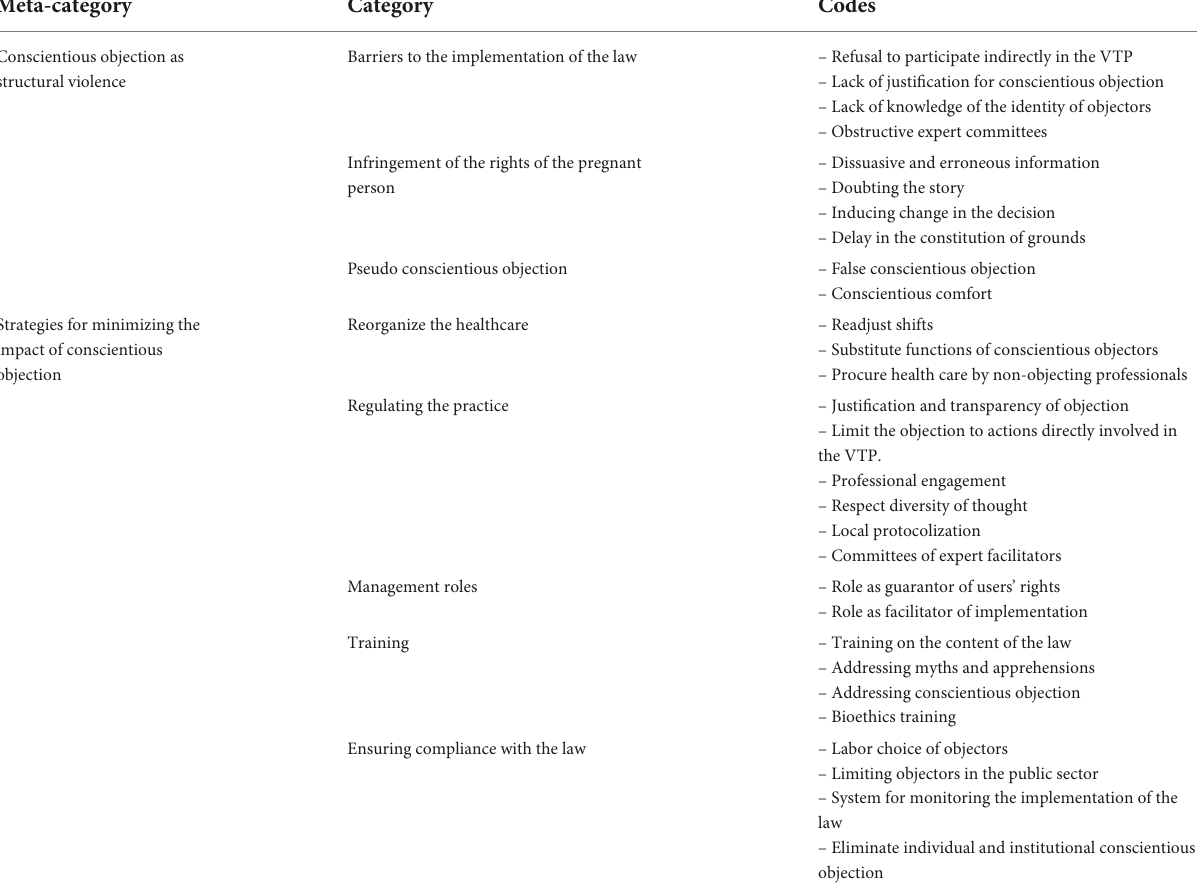
TABLE 1 Emerging categories and